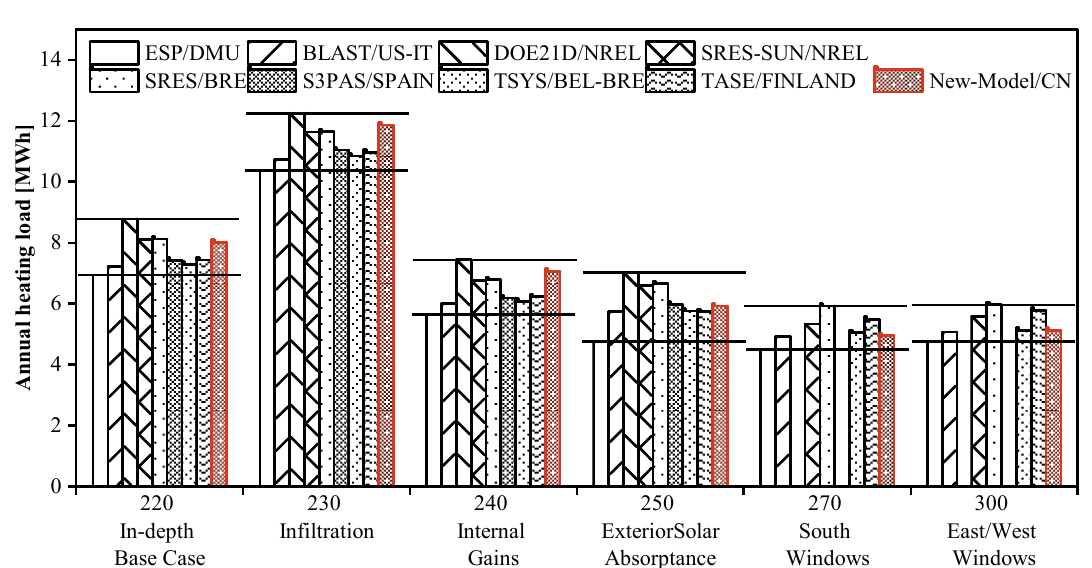
Figure 4. Annual heating load for low-mass 600-series and high-mass 900-series.